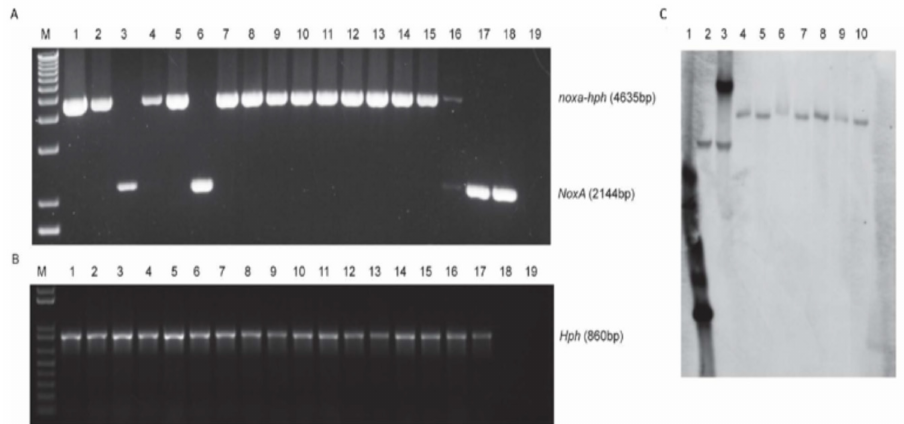
Figure 2. Identification of noxa mutants by PCR and southern blot. ( A , B ) PCR analysis of trans- formants for NoxA gene insertion. Lane M represents the DNA markers (1 Kb Plus DNA Ladder, Invitrogen, Waltham, MA, USA), lane 1 to 17 represent the transformants, lane 18 represents the genomic DNA of wild type strain Vd1396-9, and lane 19 represents the negative water control for PCR. noxa-hph : NoxA gene disrupted by inserting a DNA cassette containing both a chlorampheni- col resistance gene and a hygromycin phosphotransferase gene in the original NoxA ORF region; Hph : Hygromycin phosphotransferase gene. ( C ) Southern blot analysis of positive transformants of noxa mutants. Lane 1 represents the probe, Lane 2 represents wild type strain Vd1396-9, lane 3 represents ectopic control of NoxA insertion, and lane 4 to 10 represent positive transformants of noxa mutants. NoxA southern blot probe amplified by primers NoxA-HindIII-F and Hph-YG-F (Table 1), which contain part of DNA fragment of NoxA ORF and part of DNA fragment of the hygromycin resistant gene.